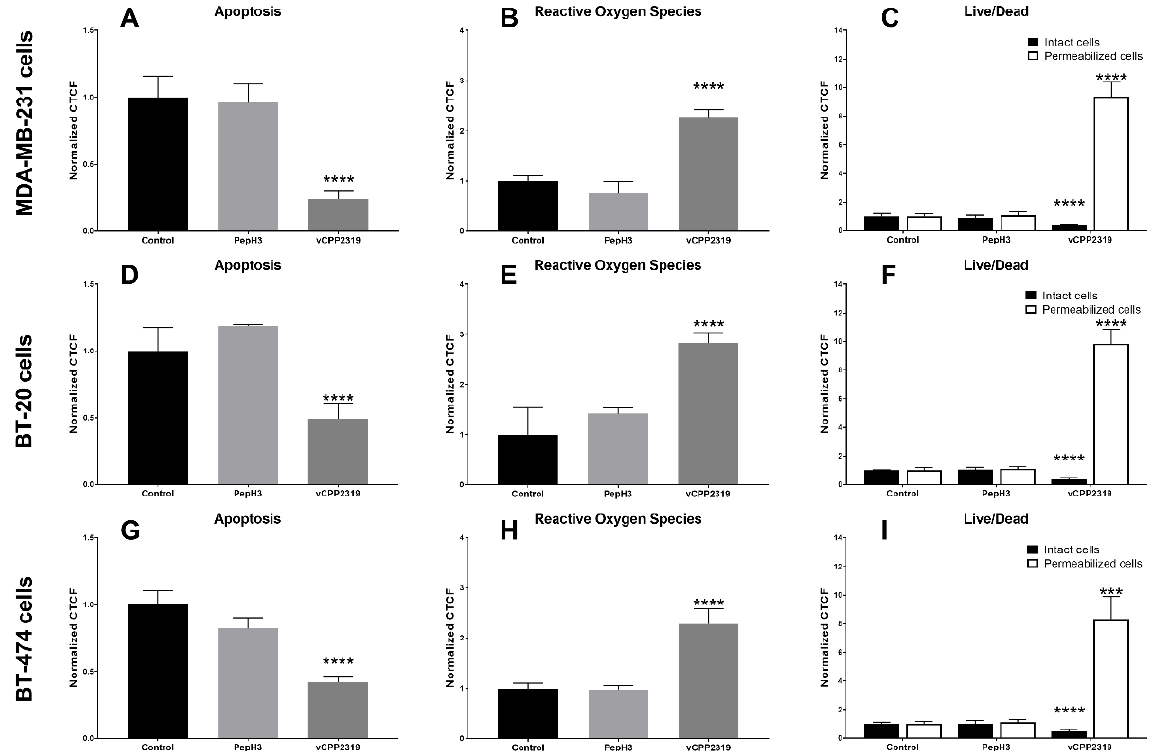
Figure 5. Confocal microscopy characterization of apoptosis, reactive oxygen species (ROS) production, and cell viabil- ity/mortality in spheroids after treatment with peptides. Apoptosis, ROS production, and cell viability/mortality of ( A – C ) MDA-MB-231, ( D – F ) BT-20, and ( G – I ) BT-474 spheroids, formed under optimized conditions, after treatment for 5 days with vCPP2319 and PepH3 were assessed using a confocal point-scanning Zeiss LSM 880 microscope. The analysis was performed by calculating the corrected total cell fluorescence (CTCF) of different images and CTCF normalized to control. Graphs represent at least triplicate biological repeats, and results are displayed as mean ± SD, where * p < 0.05, ** p < 0.01, *** p < 0.001, and **** p < 0.0001.